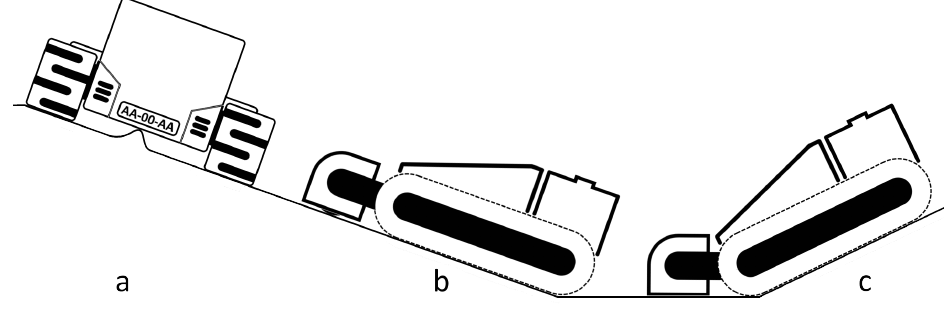
Figure 5. Key metrics: ( a ) lateral slope angle and ground clearance; ( b ) climbing angle; ( c ) approach